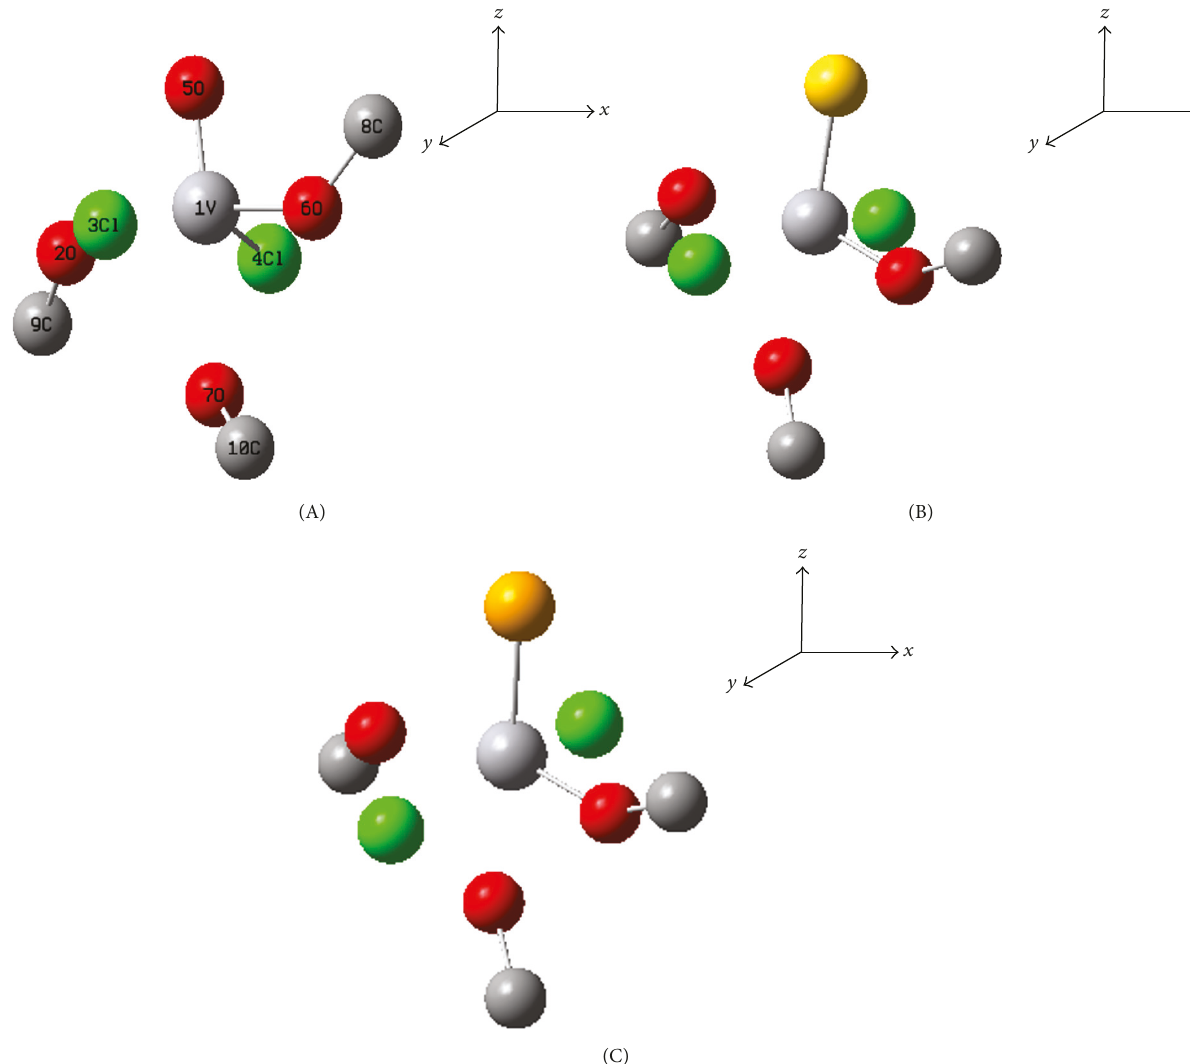
Figure 1: Optimized geometries of the respective complexes. A: VOCl 2 (OMe)(HOMe) 2 , B: VSCl 2 (OMe)(HOMe) 2 , and C: VSeCl 2 (OMe)(HOMe) 2 . Hydrogen atoms have been removed for